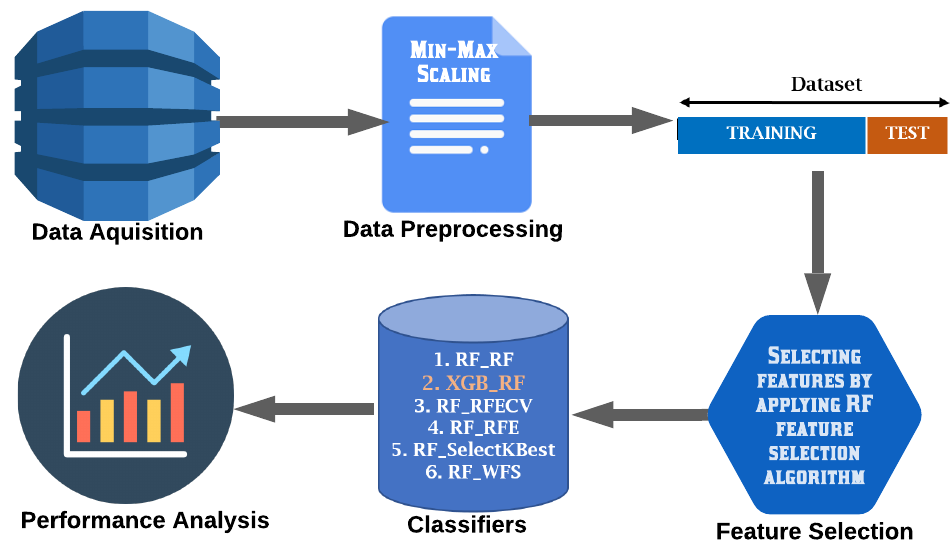
Figure 1. Workflow diagram of the proposed